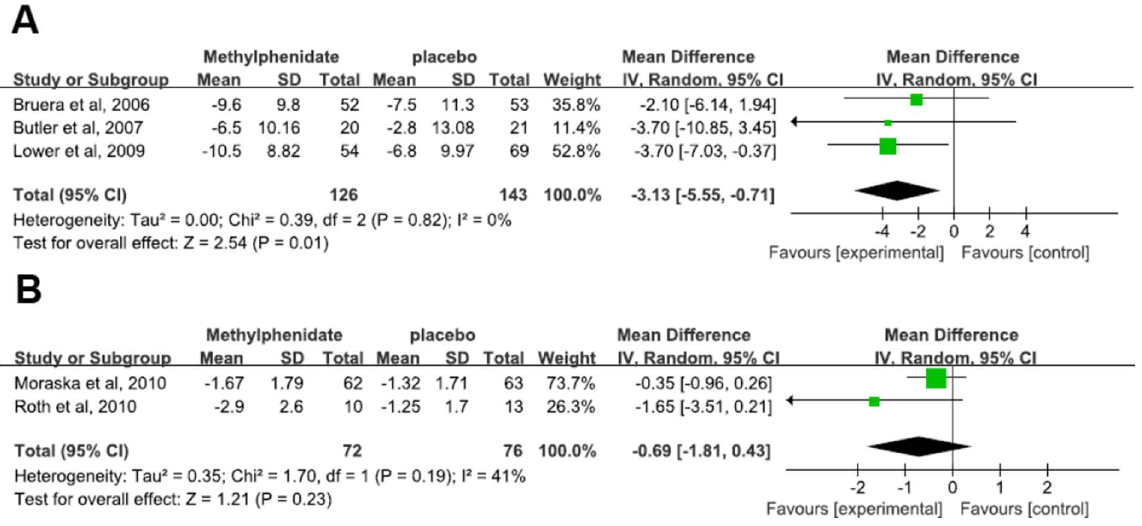
Figure 2. Effects of Methylphenidate on Cancer-Related Fatigue measured by the FACT-F (A) and the BFI (B).